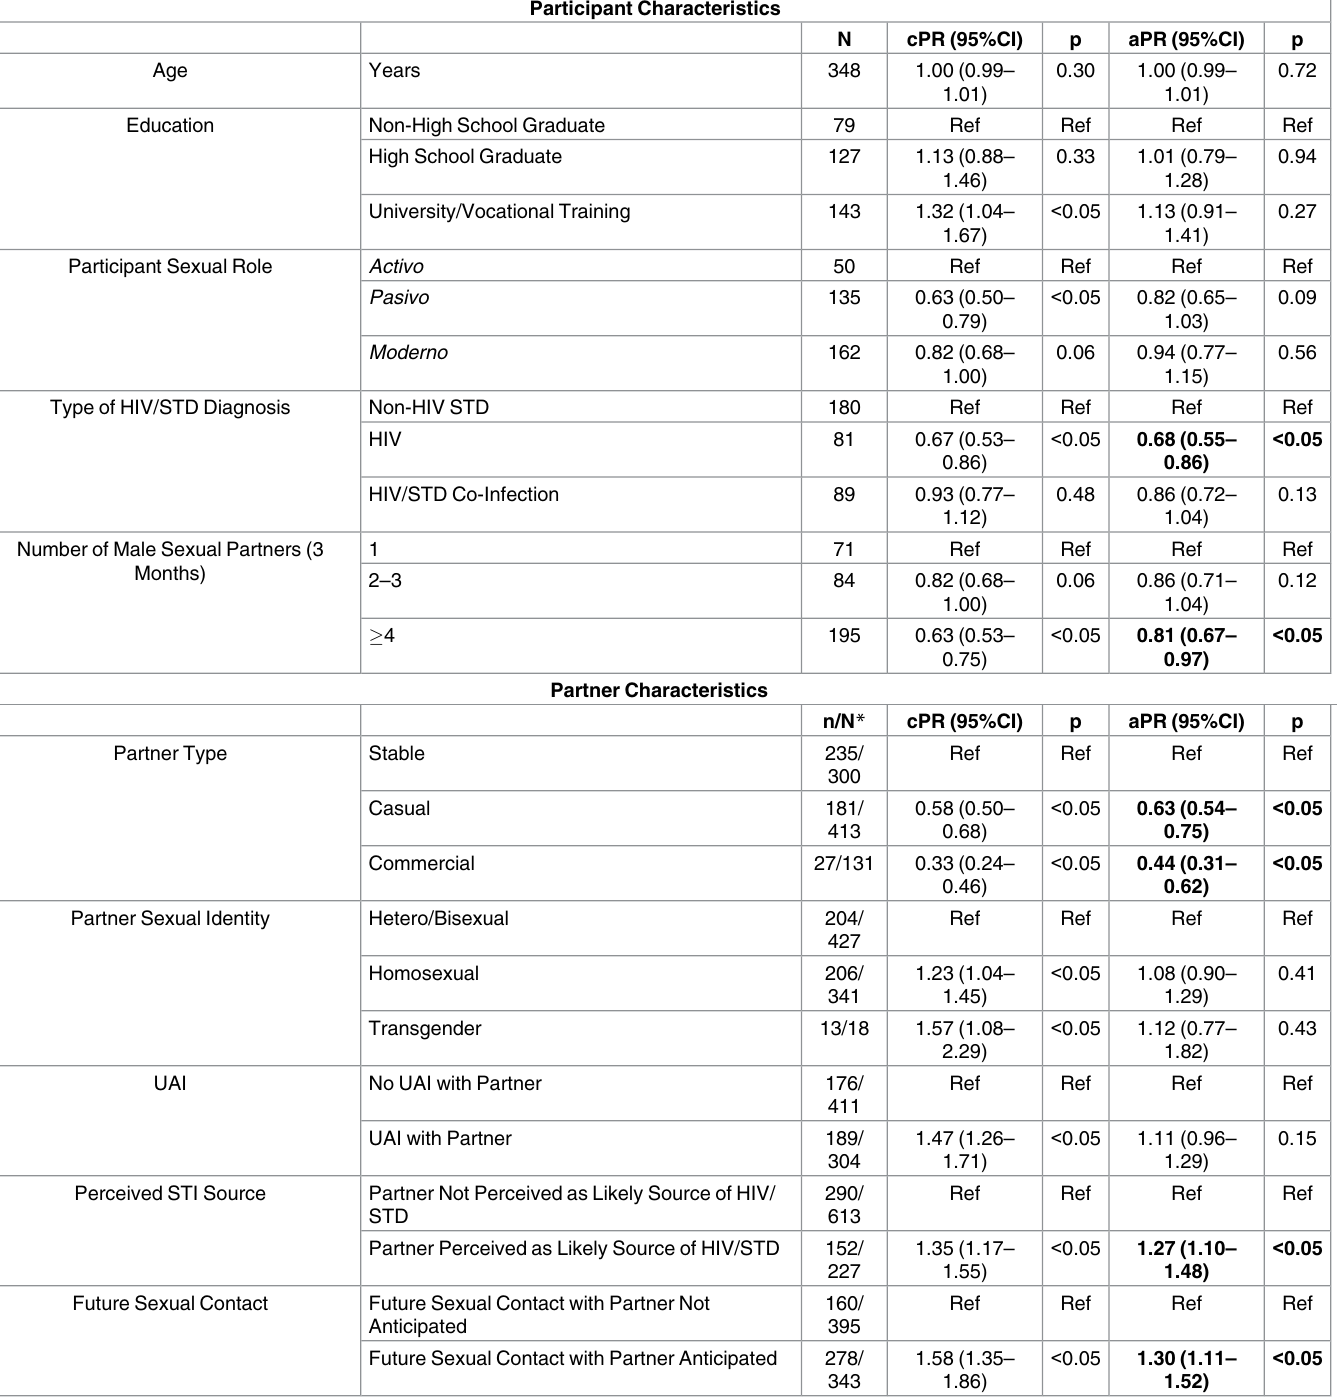
Table 3. Participant and Partner Characteristics Associated with Anticipated Partner Notification Among MSM/TW Recently Diagnosed with HIV and/or STD; Lima, Peru